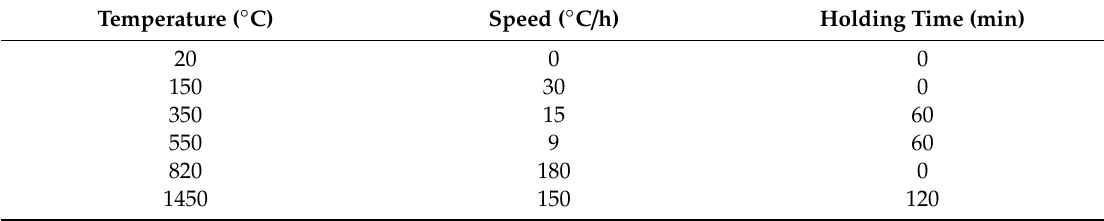
Figure 3. Temperature history for thermal debinding and sintering steps. Table 2. Thermal debinding and sintering steps